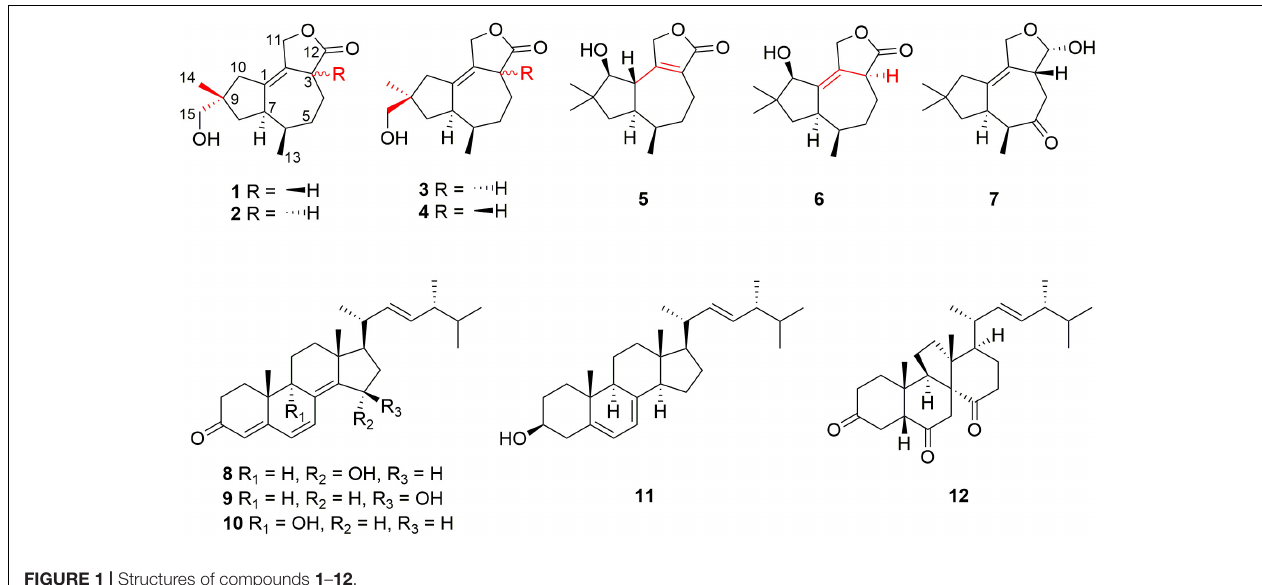
FIGURE 1 | Structures of compounds 1 – 12 .